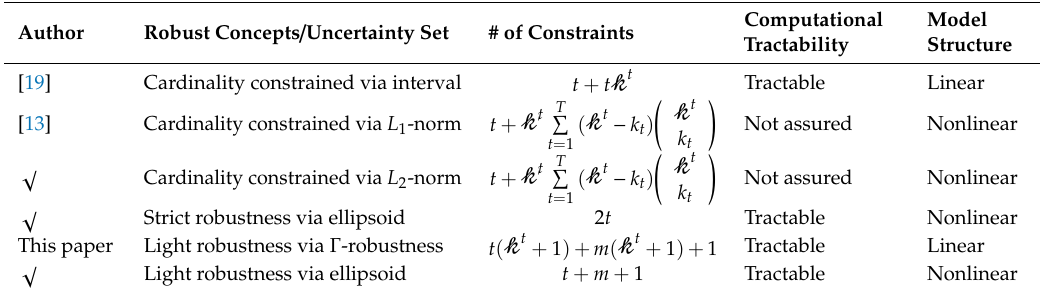
Table 1. Dimensions of the robust goal programming (RGP)